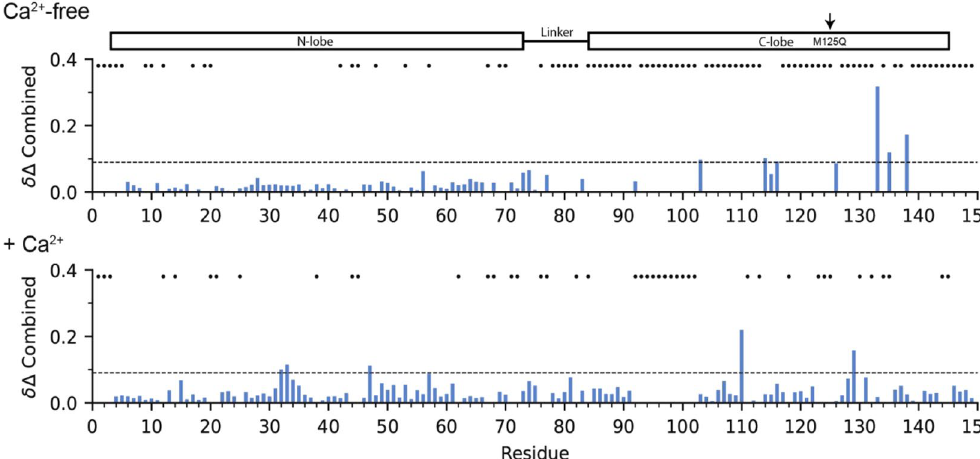
Figure 2. M125Q mutation alters CaM’s C-terminal domain. Combined 1 H/ 15 N chemical shift perturbations for M125Q-CaM in the absence and presence of Ca 2+ , relative to WT-CaM based on [ 1 H, 15 N] HSQC spectra. The dashed line represents two standard deviations (0.09) within the data. Asterisks indicate missing peaks or unassigned residues. NMR Spectra were analyzed using NMRFAM-Sparky 46 .